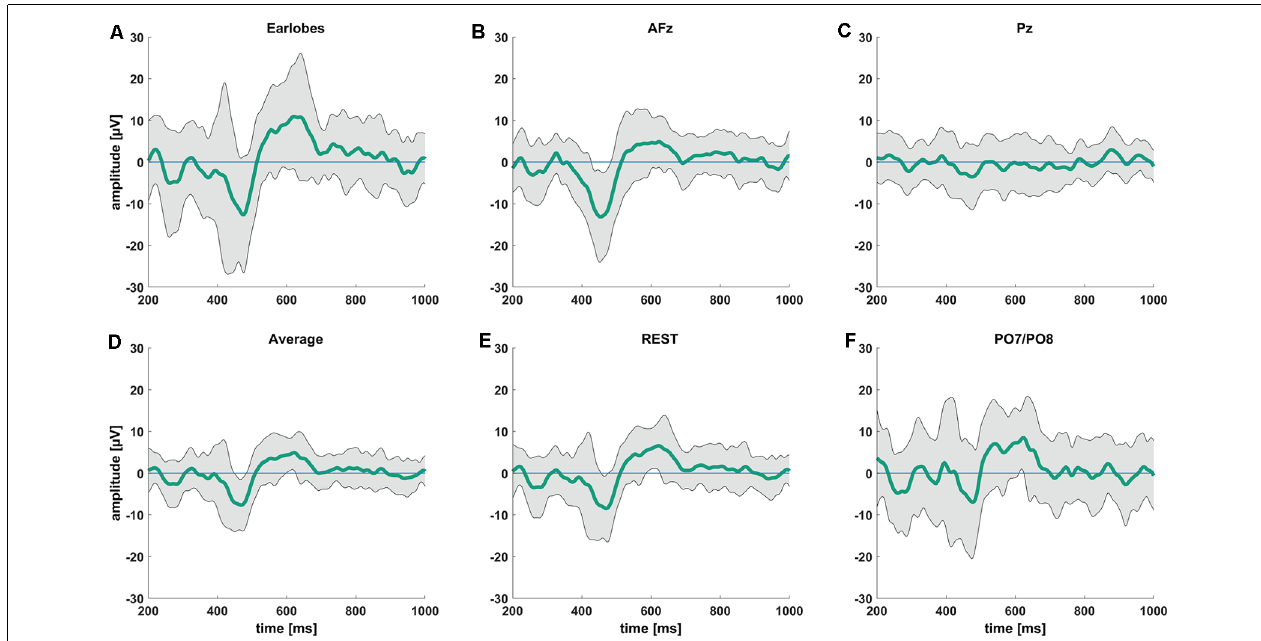
FIGURE 2 | Average contact heat evoked potentials (CHEPS) waveforms from 200 ms to 1,000 ms following the stimulus at 54 ◦ C stimulation temperature. The green line indicates the average amplitude at the Cz electrode location with (A) mathematically linked earlobes A1/A2, (B) AFz, (C) Pz, (D) average, (E) REST, and (F) mathematically linked PO7/PO8 as the reference sites.